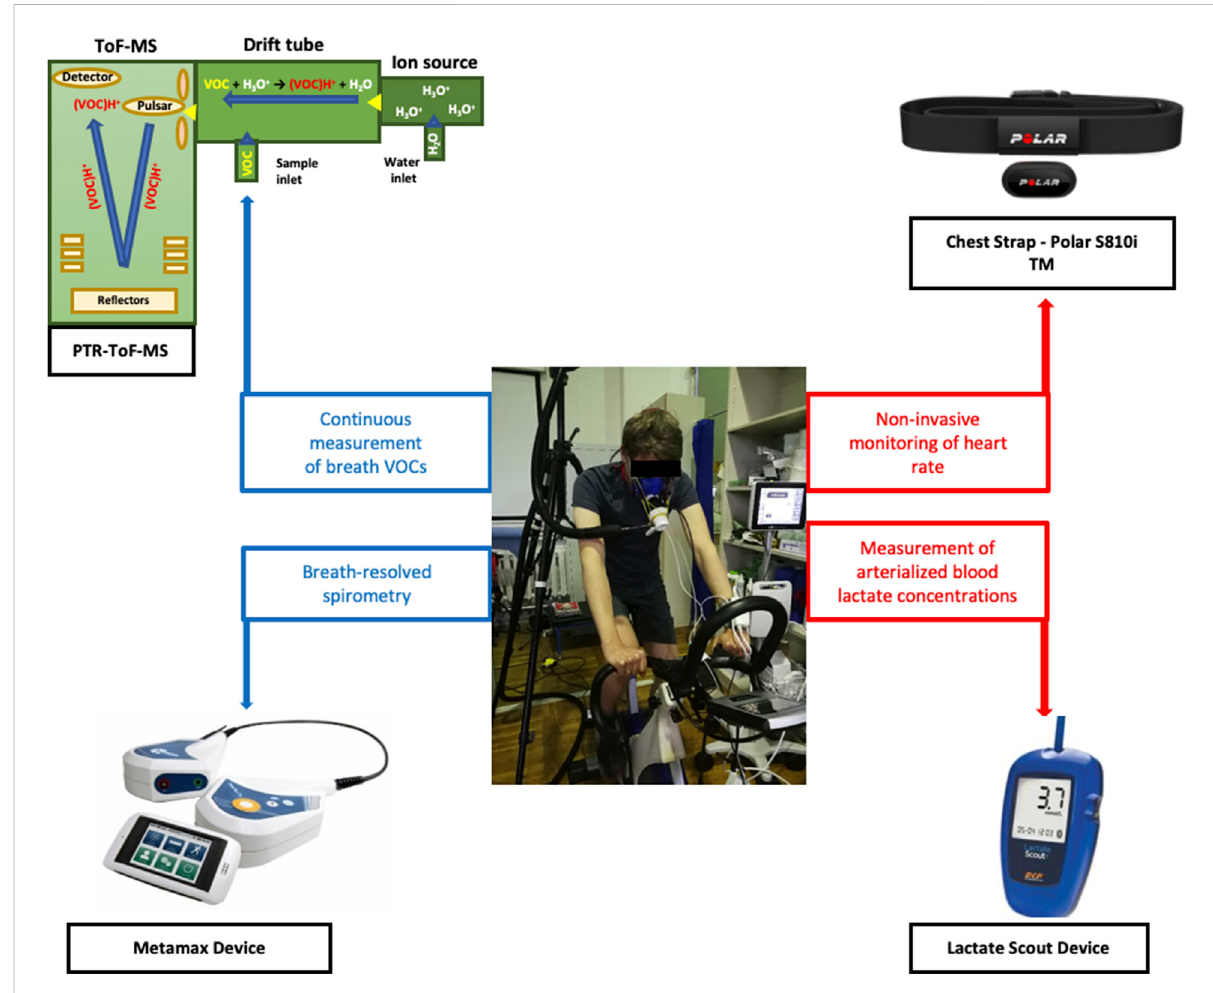
FIGURE 1 Overview of the experimental setup and instruments. A test subject on the cycle-ergometer along with four analytical instruments are presented.